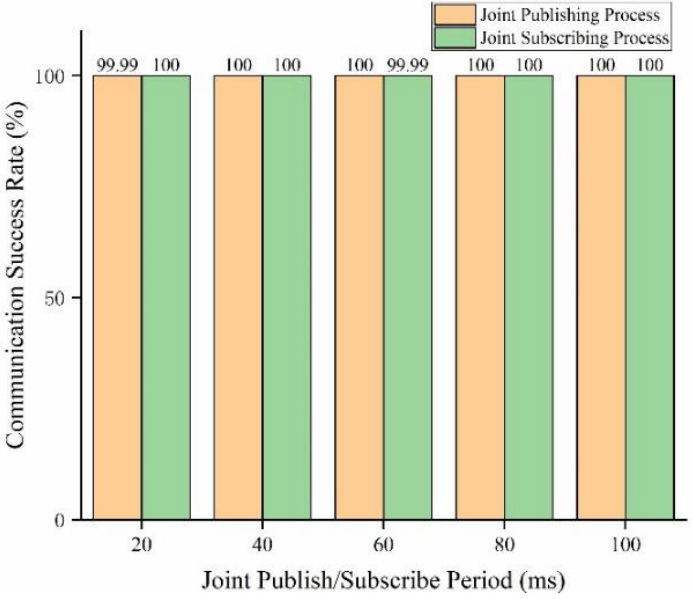
Figure 14. Communication success rate of WIA-PA/OPC UA joint pub/sub.